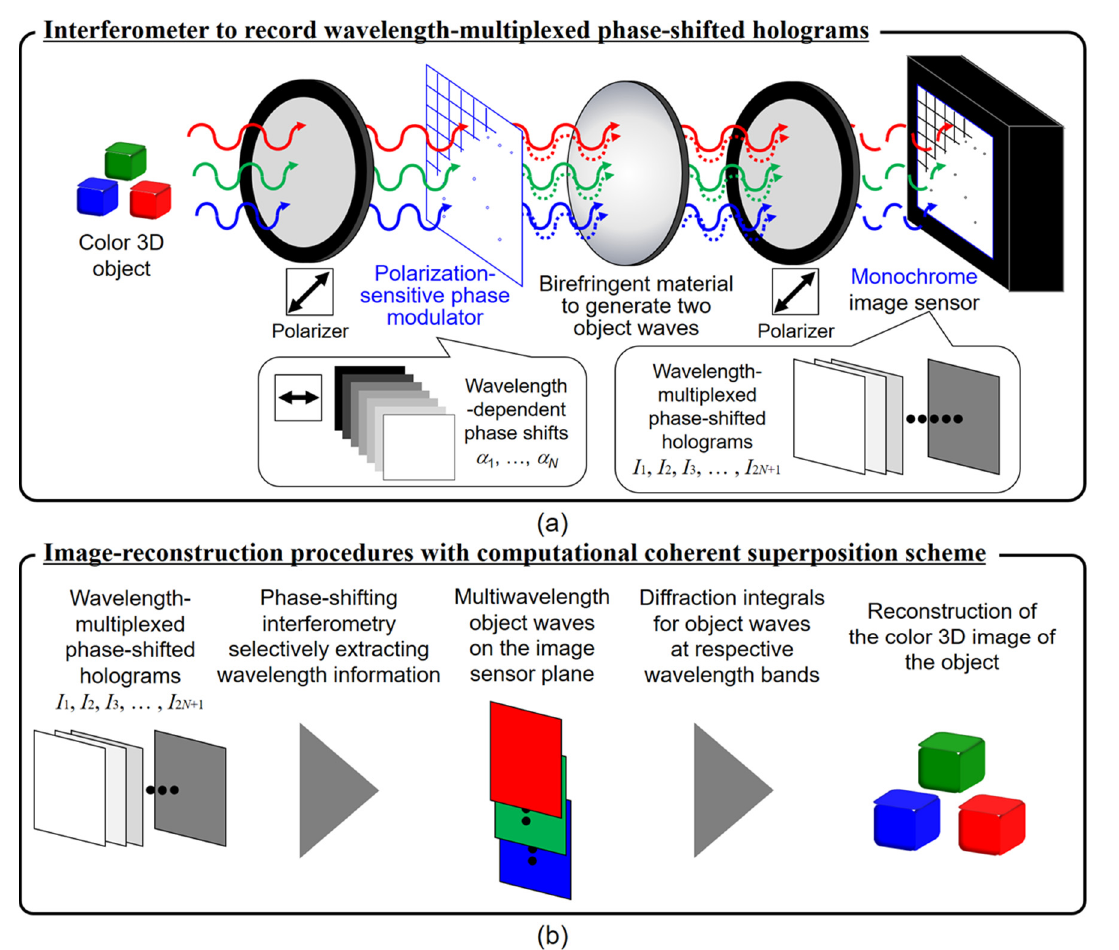
Figure 26. Schematic of CCS. ( a ) A self-interference digital holography system with CCS and FINCH. ( b ) Image-reconstruction procedures.